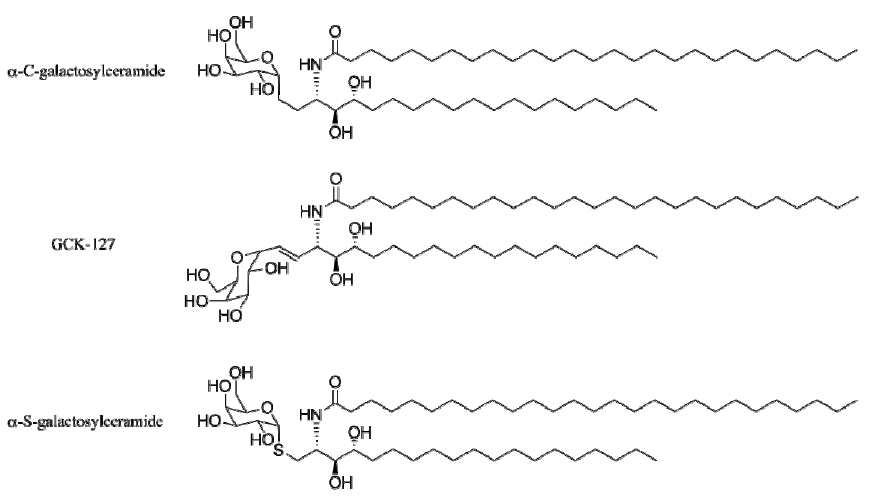
Figure 6. C-glycoside antigens for iNKT